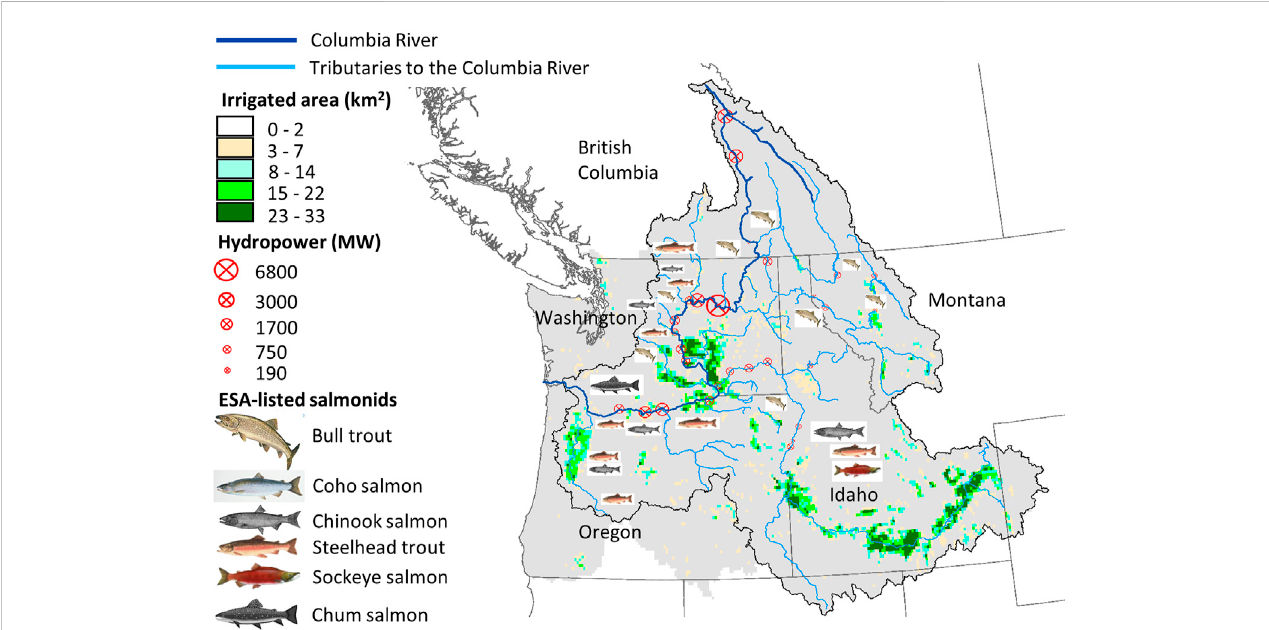
FIGURE 1 Food, energy and water subsystems of the Columbia River Basin (CRB). The black boundary delineates the CRB, and the light grey area corresponds to theCRBinclusive ofwestern Washington and mostofOregon(extendedCRB).The density ofirrigatedarea isinunits ofkm 2 per 1/16-degree gridcell.Critical habitat for ESA-listed salmonids are marked with the fi sh symbols. Locations of hydroelectric dams are shown with a red, crossed circle, with symbol size proportional to the square root of generating capacity.